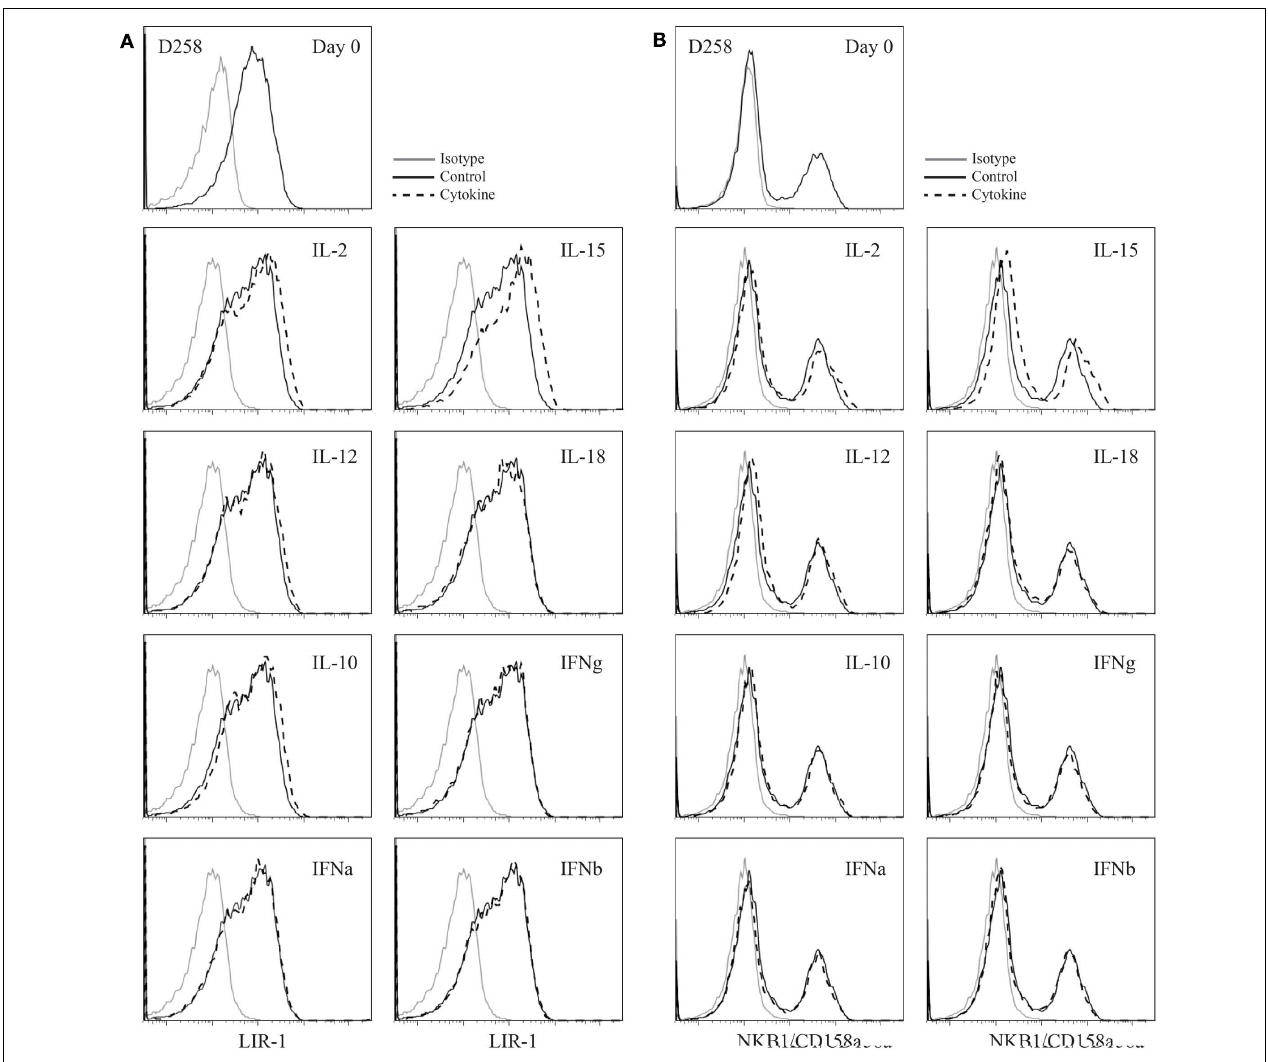
in combination with the cytokines indicated and examined for LIR-1 expression compared to control. (B) D258 NK cells were cultured as in (A) and examined for pooled KIR expression on day